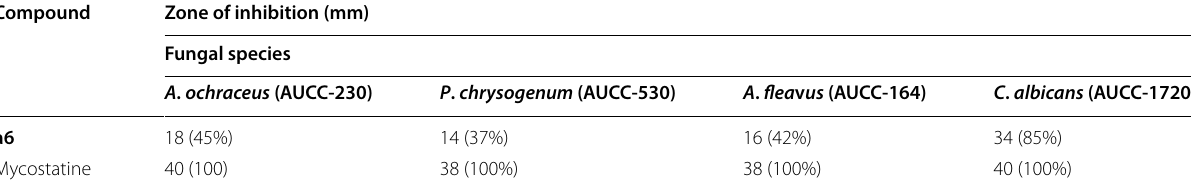
Table 3 Antifungal activity of synthesized compound a6 Compound